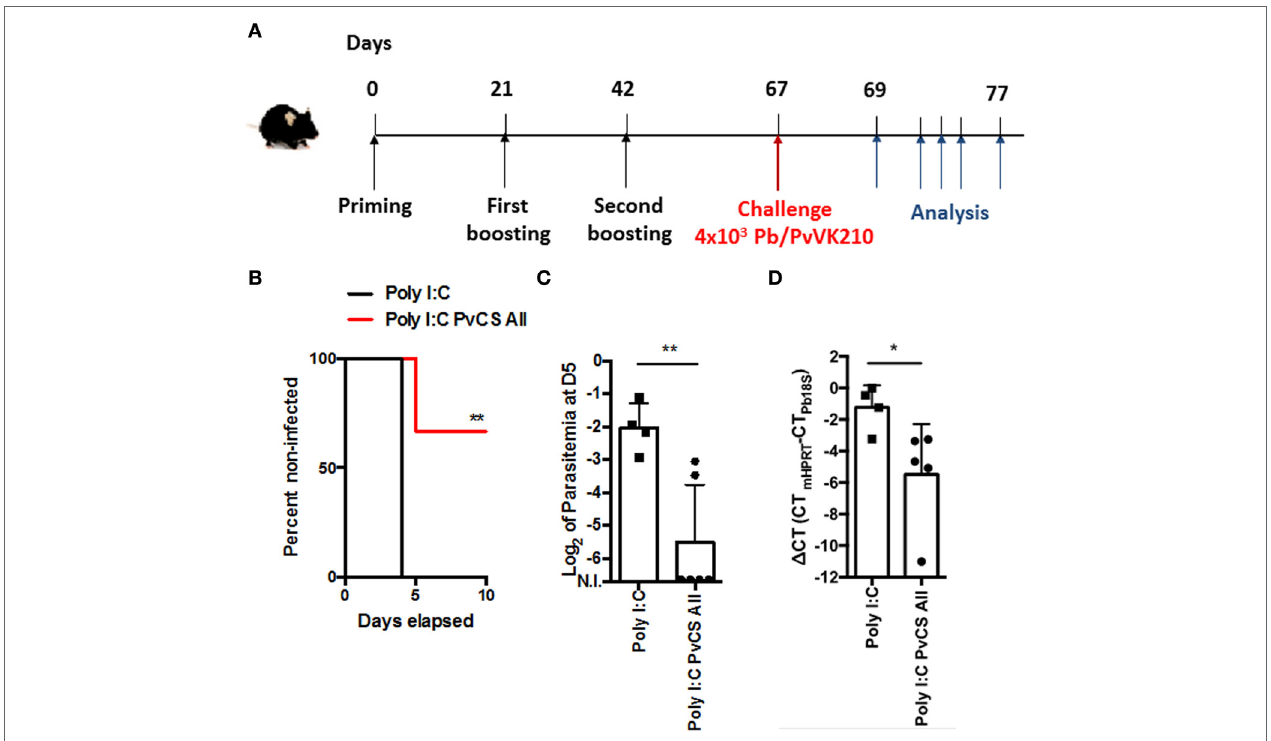
FigUre 8 | Protection against experimental challenge in mice immunized with a prime-boost regimen. (a) C57BL/6 mice were immunized i.p. with Poly(I:C) or a mixture of Poly(I:C) plus 5 µg of yPvCSP-All epitopes following the scheme described. On day 67 after priming, mice were challenged with 4,000 Pb/PvVK210 transgenic sporozoites. (B) Parasitemia was analyzed by Giemsa-stained blood smears on the following 10 days. Percentage of non-infected mice in each experimental group are shown. (c) Log of parasitemia at day 5 (D5) postchallenge measured in mice immunized with Poly(I:C) ( n = 4) or a mixture of Poly(I:C) plus 5 µg of yPvCSP-All epitopes ( n = 6). (**) P = 0.0095. (D) The liver load was evaluated by RT-PCR. The infection level in liver in mice immunized with a mixture of Poly(I:C) plus 5 µg of yPvCSP-All epitopes ( n = 5) is compared with control group that received Poly(I:C) alone ( n = 4). (*) P = 0.0159 . C-terminal (CT) differences (delta CT) between the mouse HPRT and Pb 18S CT values are